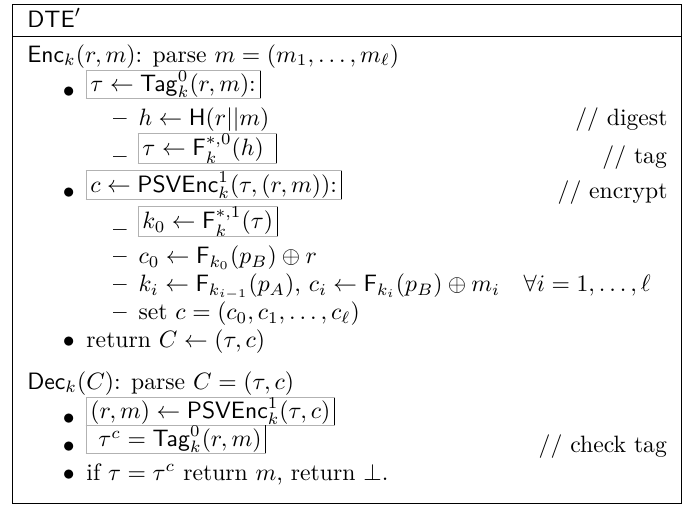
Table 3: DTE ’ leakage-resilient authenticated